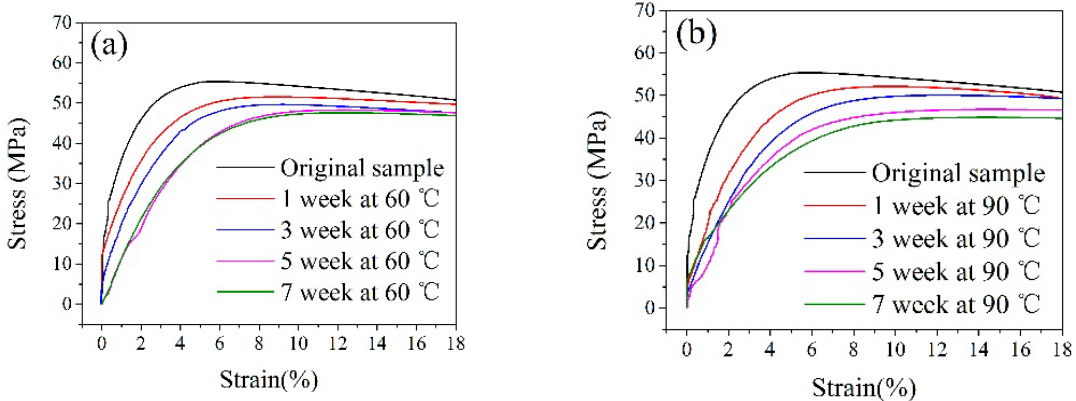
Figure 3. The stress–strain curves of PVDF samples at different exposure times: ( a ) 60 °C; ( b ) 90 °C.